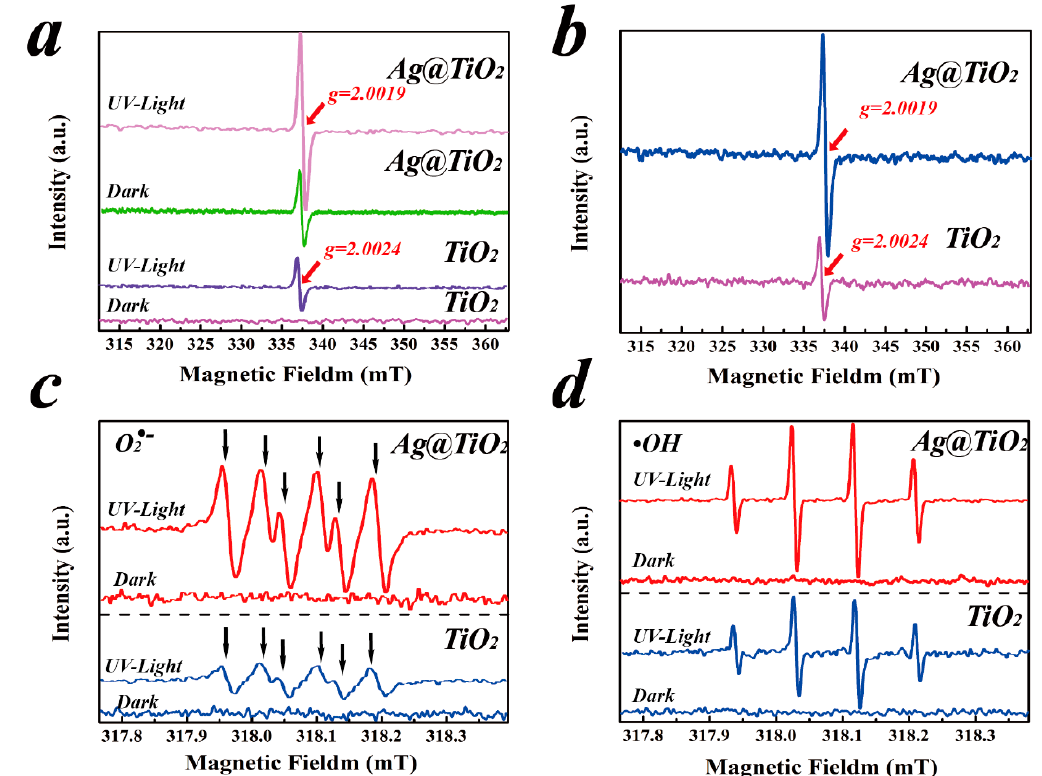
Figure 8. ( a ) EPR spectra in activation of the as prepared Ag@TiO 2 (0.06 wt %) and pure TiO 2 powder; ( b ) EPR difference spectrum between dark and UV-light of TiO 2 and Ag@TiO 2 ; ( c ) EPR spectra of radical adducts trapped by DMPO in TiO 2 and Ag@TiO 2 dispersions under UV light irradiation: DMPO-O 2• − formed in irradiated methanol dispersions; ( d ) DMPO- • OH formed in irradiated aqueous dispersions. Reaction conditions: [Ag@TiO 2 ] = 1 mg/mL, [TiO 2 ] = 1 mg/mL, [DMPO] = 100 mM, [Illumination time] = 5 min.